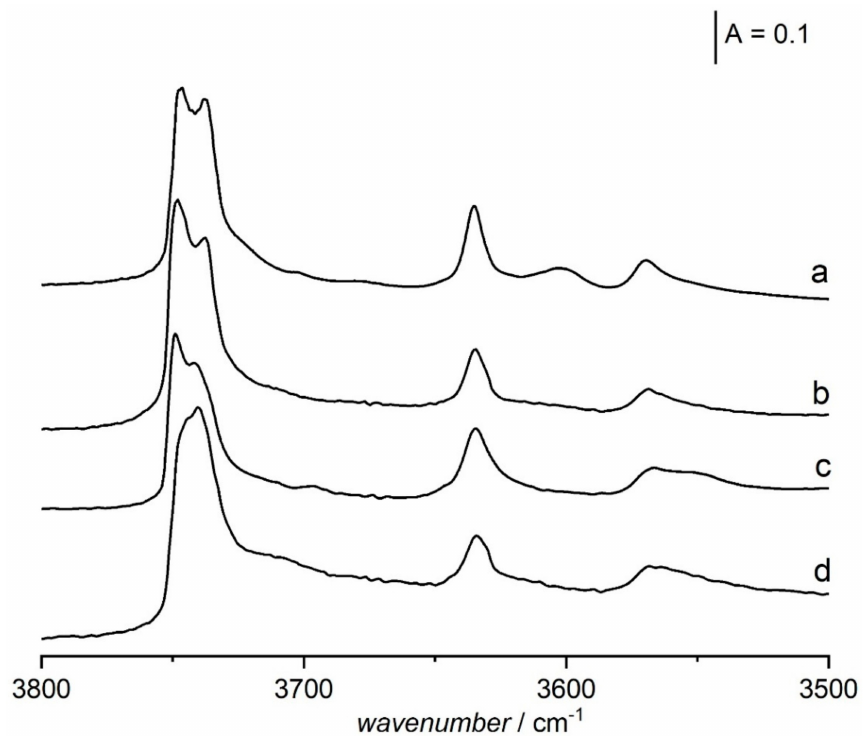
Figure 6. The spectra of OH groups in zeolite Y desilicated in which TBA + ions were removed by: a - calcination in atmospheric air at 790 K, b - oxidation in oxygen at 790 K, c- calcination in vacuum at 720 K, d - calcination in dry air at 790 K. All the spectra were recorded at 170 K. Figure adapted with the permission from